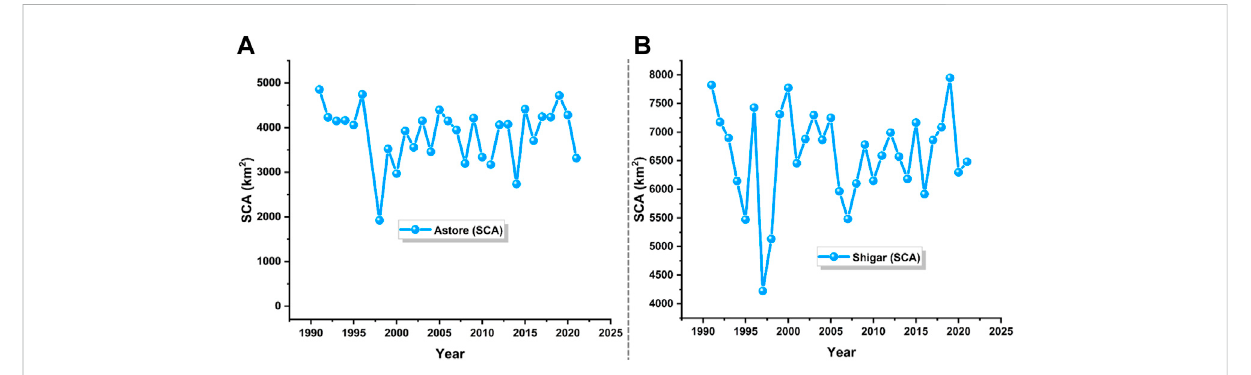
FIGURE 4 Inter-annual SCA variability for (A) Astore and (B) Shigar.